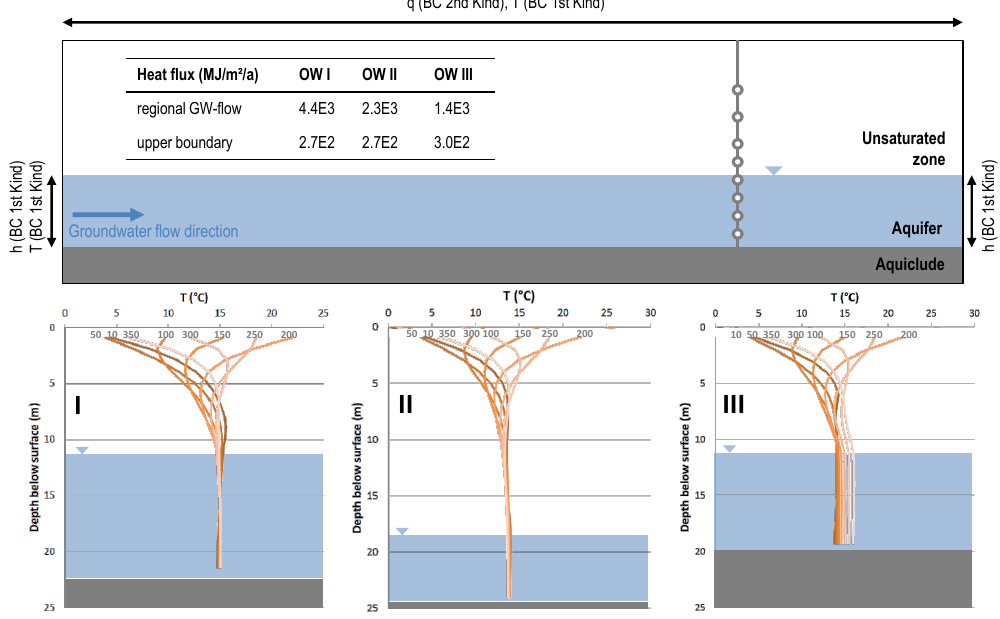
Fig. 3. Top panel: conceptual setup for local 2-D (I and II; for locations see Fig. 1) and 3-D (III; for location see Fig. 1) models, including model boundary conditions for flow and heat transport and a schematically representation of a multilevel temperature measurement device within the flow field; the imbedded table summarizes the cumulated yearly heat fluxes across selected model boundaries for three of the multilevel observation wells. Bottom panel: modeled temperature tautochrones for three of the multilevel observation wells; grey numbers represent tautochrones of selected days in the year